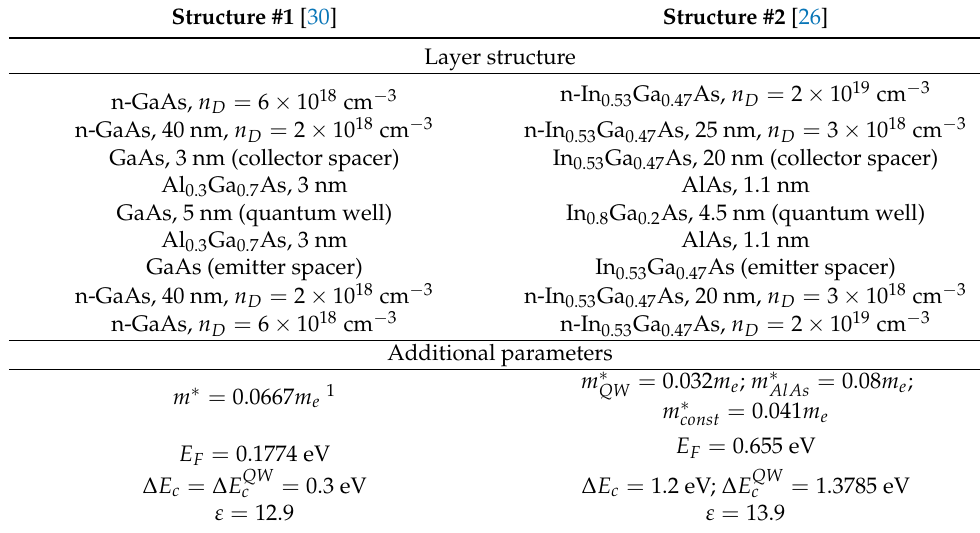
Table 1. Parameters of the investigated resonant tunneling nanostructures.